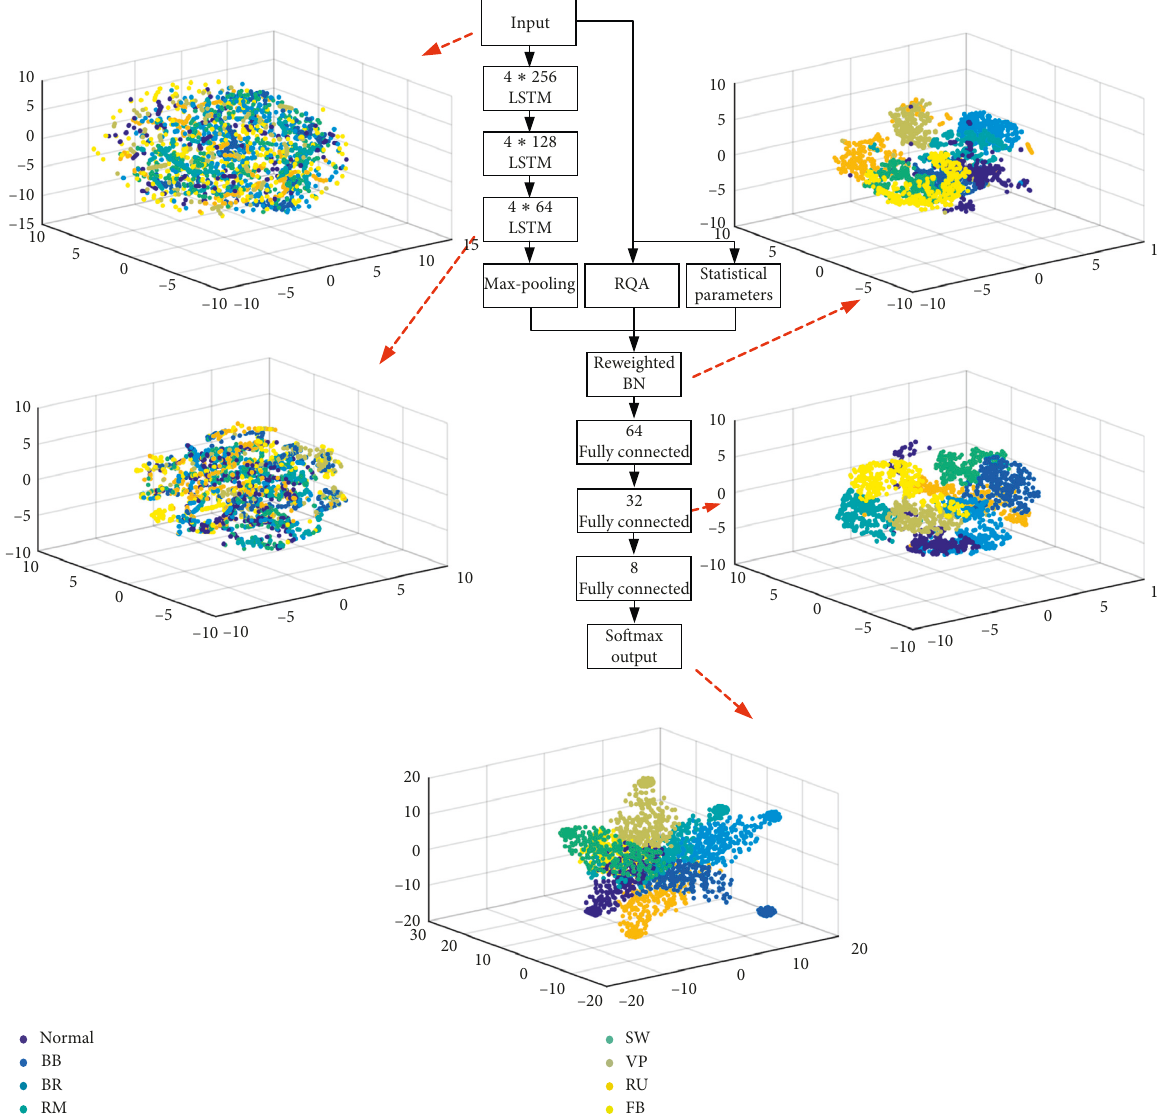
Figure 13: 3D representations of high-dimensional outputs at different layers with dataset 2 by